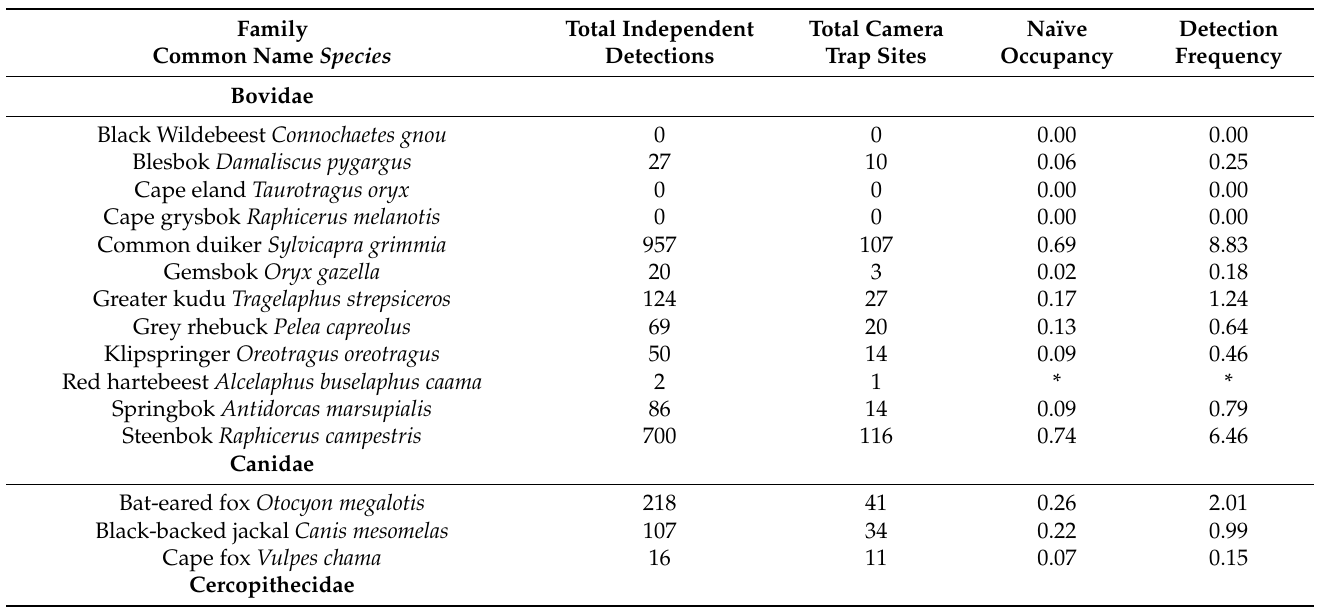
Table A2. General results of the camera trapping surveys conducted on the farmland, presented per family and species. Shaded in light grey, the species/families that are absent or were not detected. Shaded in blue, the species/families that are true (i.e., known) absences. Total independent detections indicate the sum of independent detections, and the naïve occupancy is the proportion of camera trap sites at which the species was detected. The detection frequency (or relative abundance index [RAI]) is the camera trapping